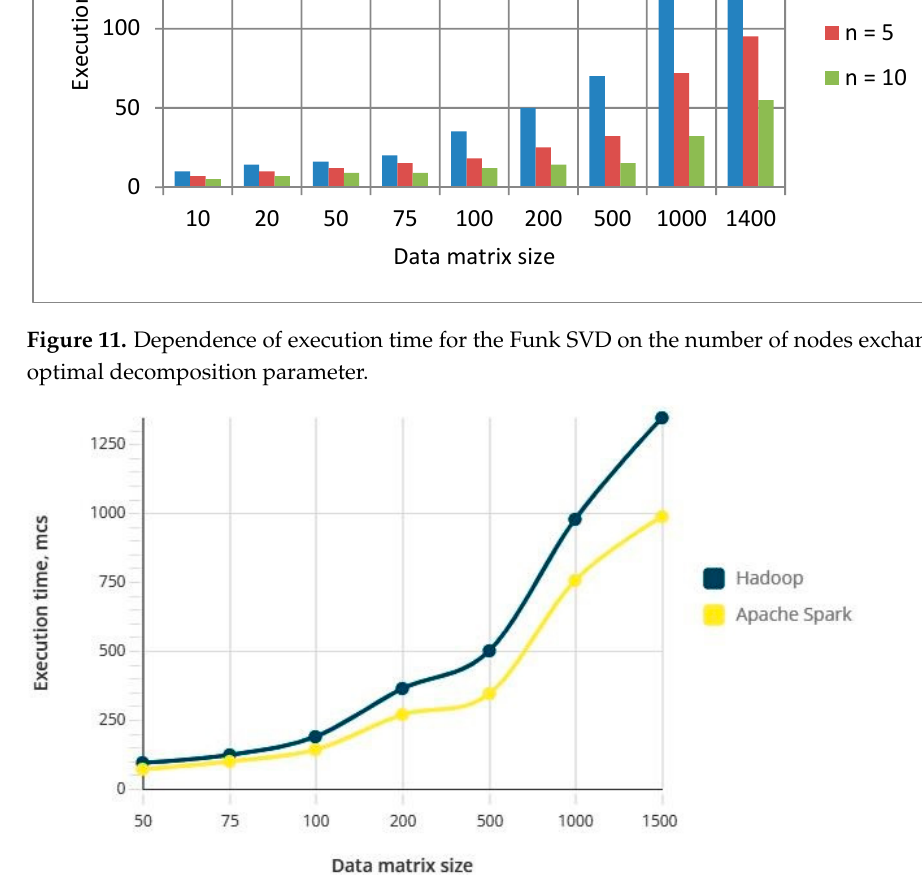
Figure 11. Dependence of execution time for the Funk SVD on the number of nodes exchanging the optimal decomposition parameter.